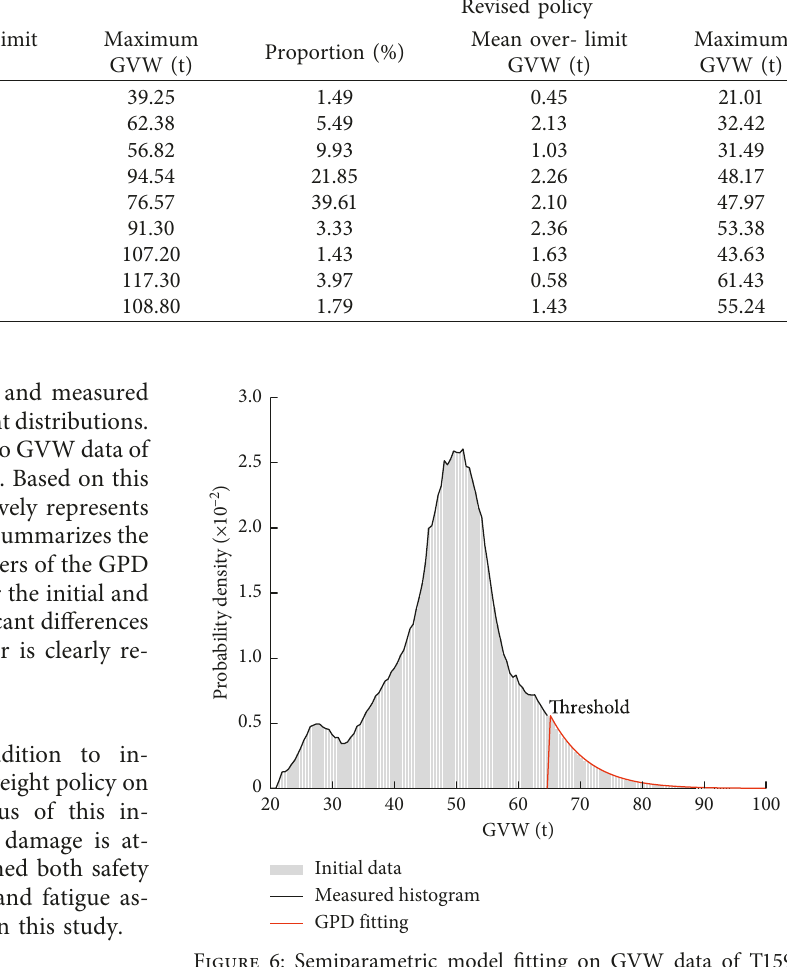
Table 8: Frequency and extent of truck overloading under the initial and revised toll-by-weight policies. Truck type